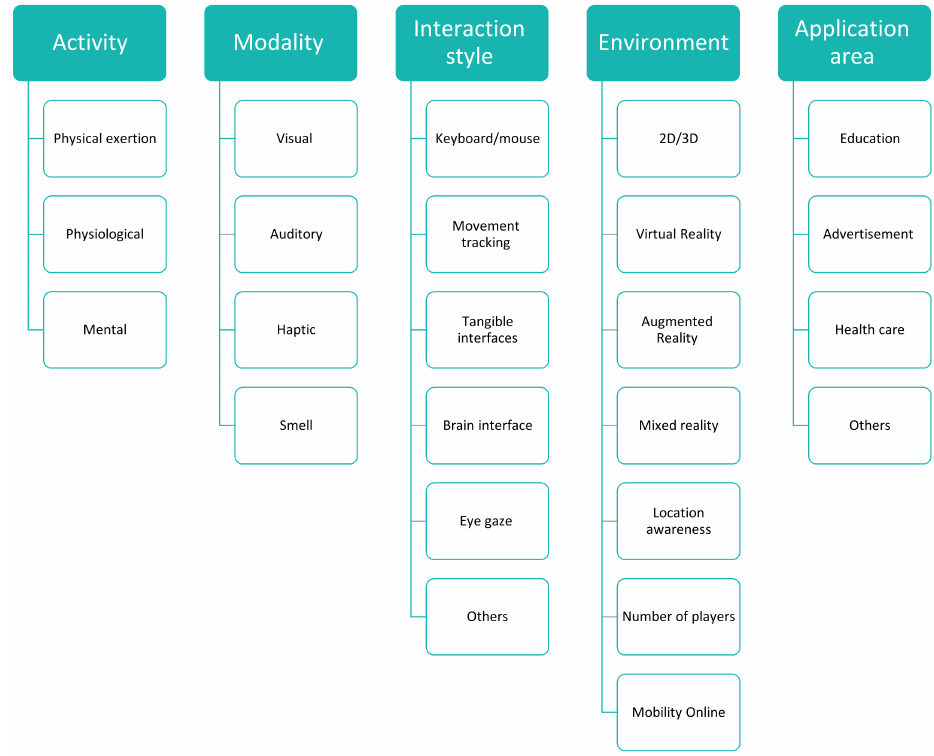
Figure 4. Serious Games Standards.